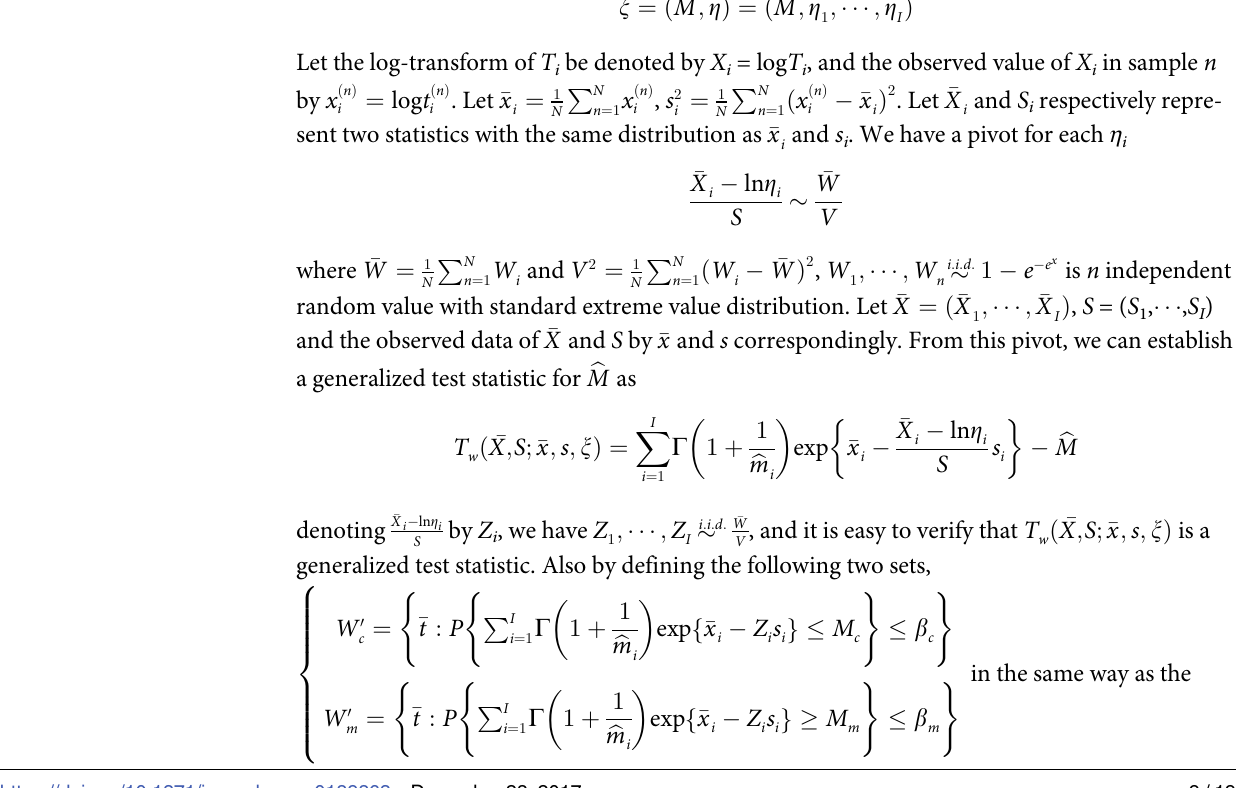
of shape parameter m i